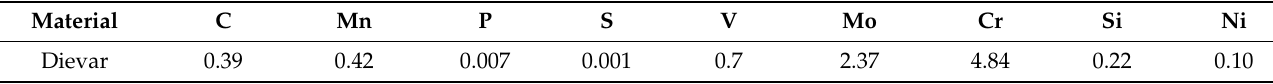
Table 1. The chemical composition of Dievar steel (wt %).